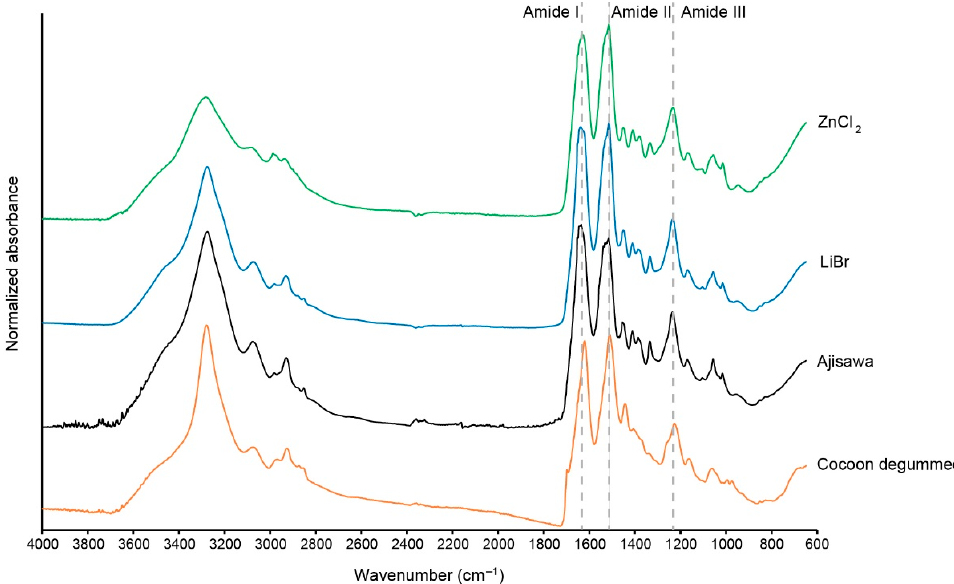
Figure 6. ATR-FTIR spectra of silk fibroin plotted as normalized absorbance versus wavenumber. Silk fibroin films cast from fibroin isolated using the three dissolution methods (Ajisawa, black; LiBr, blue; ZnCl 2 , green) were compared with degummed cocoon silk fibroin (yellow). Dashed lines show the bands for the three amides I-III. Table 2. Comparison of main bands of ATR-FTIR spectra (cm − 1 ) of silk fibroin films. Sample Random Coil Structure